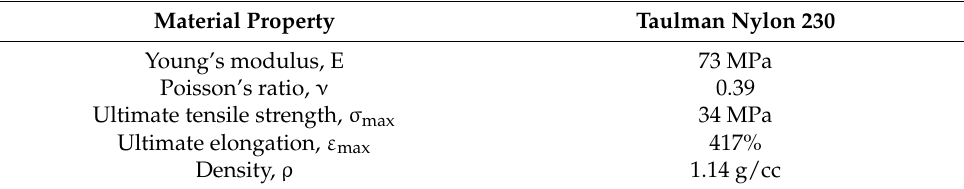
Table 1. Mechanical properties of the 3D-printed Taulman Nylon